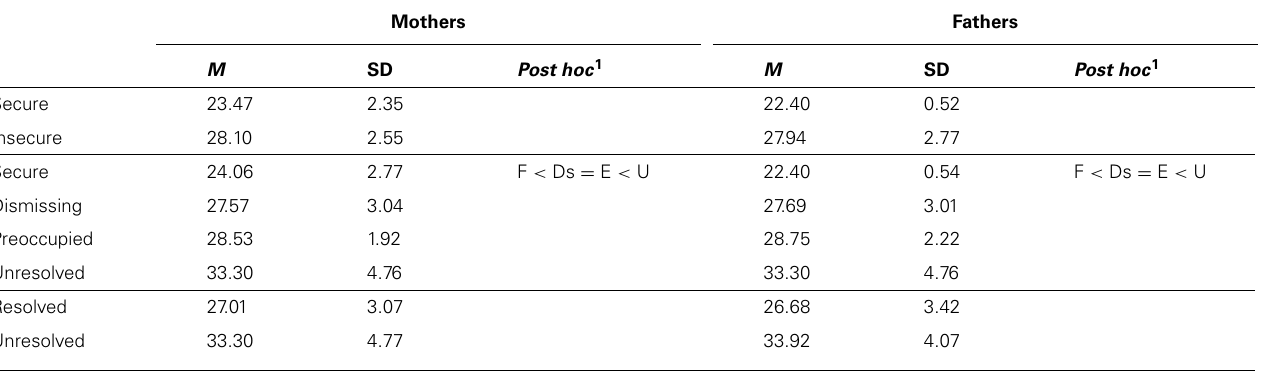
Table 3 | Means and standard deviations of child’s BMI for mothers’ and fathers’ attachment.